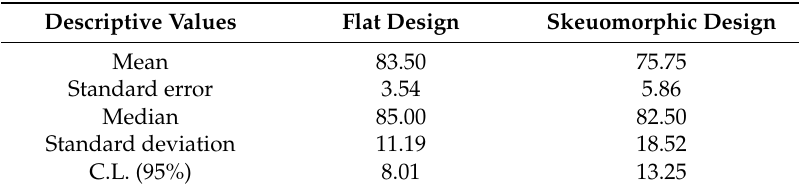
Table 19. SUS score descriptive statistics. Descriptive